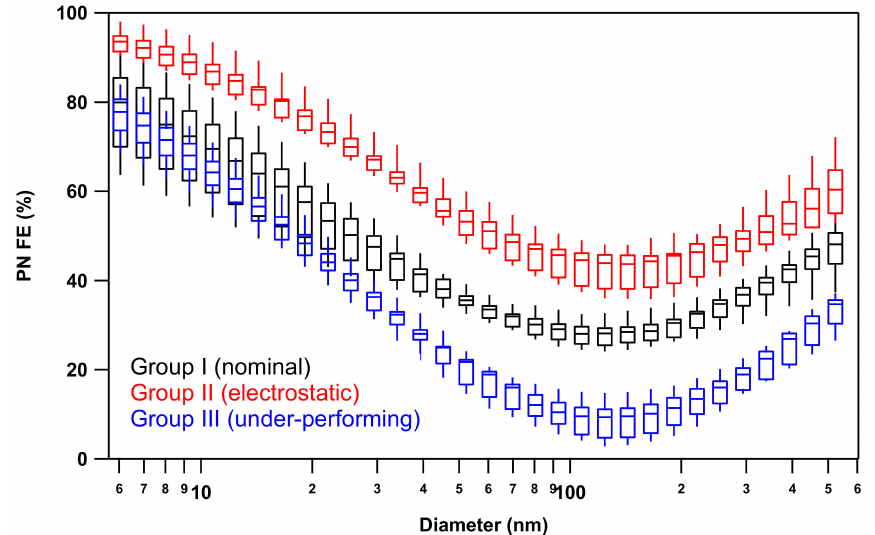
Figure 6. Average PN FE for the different filter groups. Each individual box represents the 30th, 50th, and 60th percentiles of the FE values over the course of the experiment, while the 20th and 80th percentiles are represented by the bottom and top whiskers, respectively.